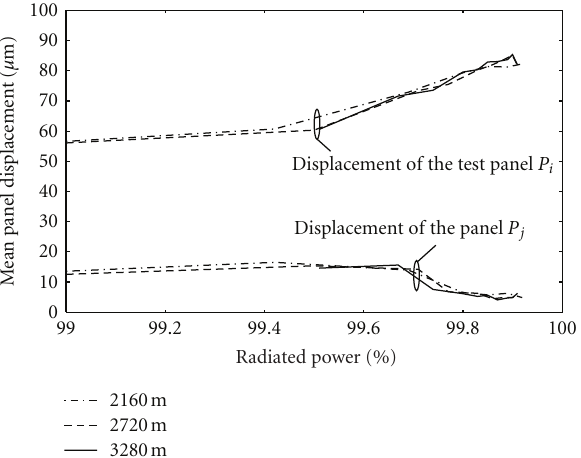
Figure 6: Deformation of 100 μ m of the panel under test P i . P j (with j / = i ) is the panel with the highest mean deformation.